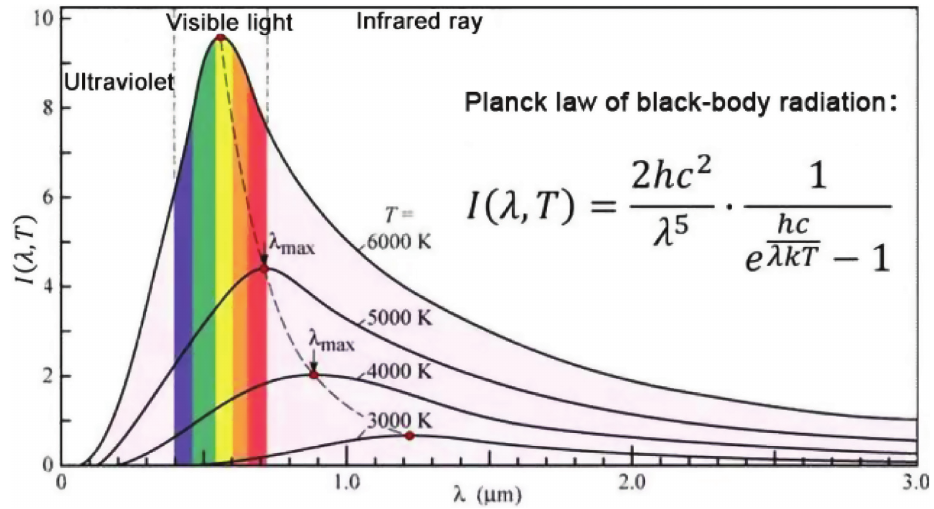
Figure 1. Experimental curves of black-body